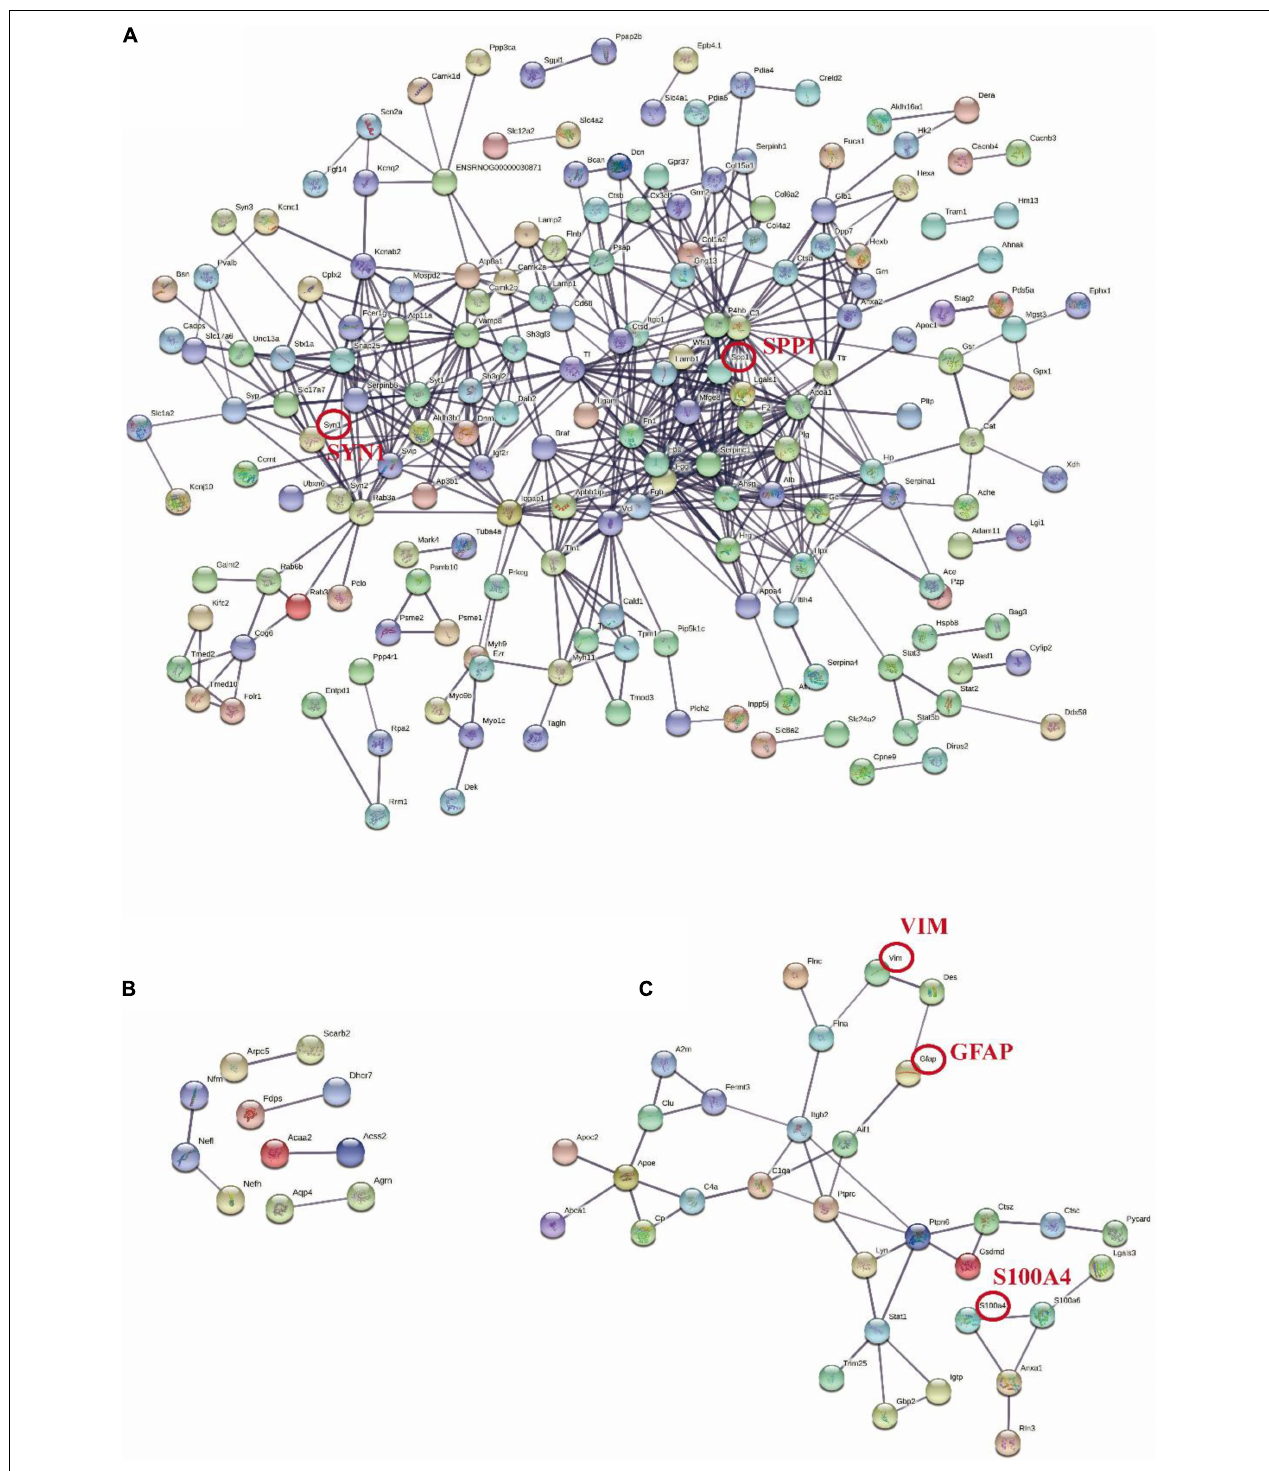
FIGURE 8 | Protein-protein interaction networks of different stages of TBI constructed in STRING. One dot represents a protein. The pattern in the node represents the predicted three-dimensional structure. Each line represents the relationship between the proteins. The thickness of the line represents the correlation strength. (Minimum required interaction score: high confidence = 0.700). (A) PPI network of 312 DEPs in the Sham-a/CCI-a groups. (B) PPI network of 76 DEPs in the Sham-s/CCI-s groups. (C) PPI network of 63 shared DEPs. According to the FC order, six proteins were randomly selected from the top 20 up-regulated and down-regulated, respectively, for verification, and five were in the network (red